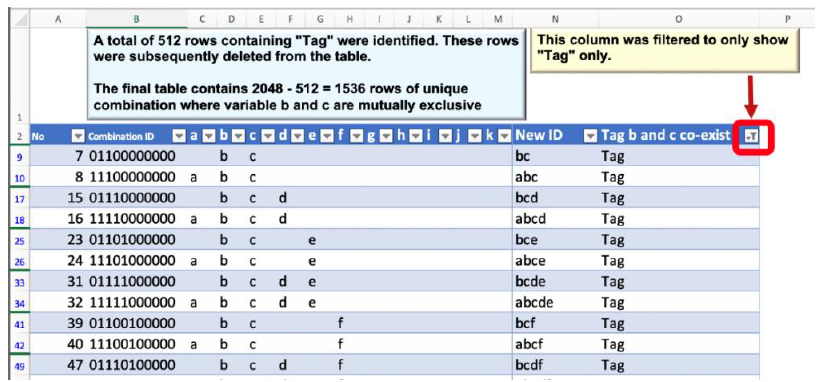
Figure 3. Turning unique bits into unique combinations of alphabetical code of predictors.